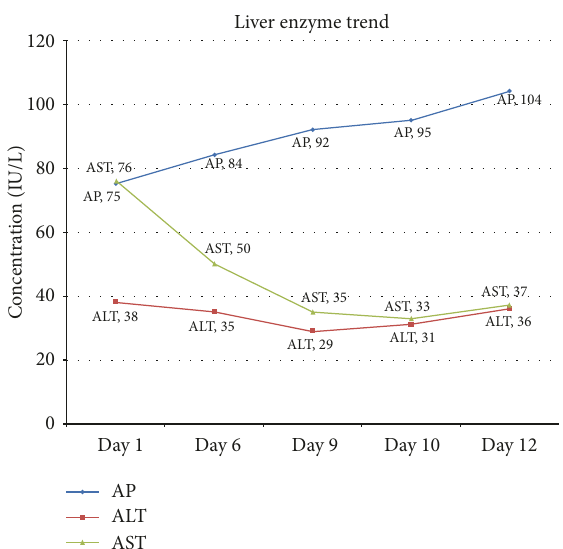
Figure 2: Trend of AST/ALT/ALP during the course of hospitaliza- tion.